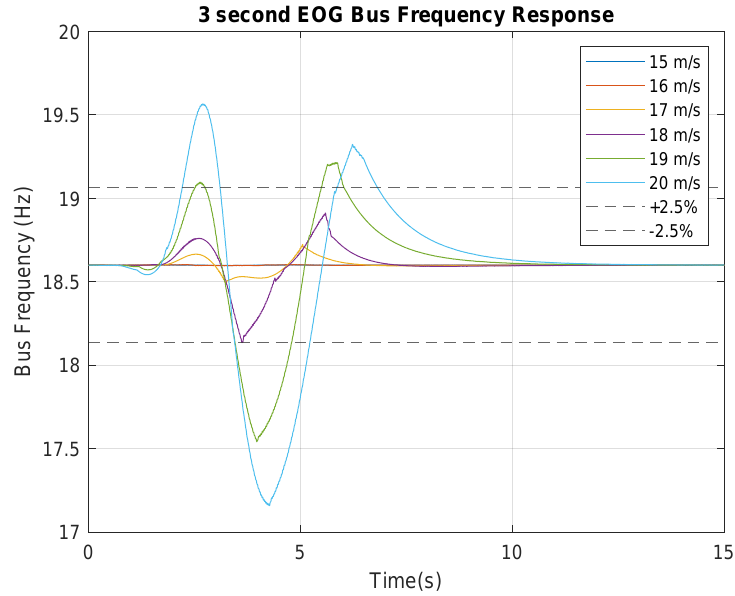
Figure 13. System frequency response to 3 s EOG gusts.